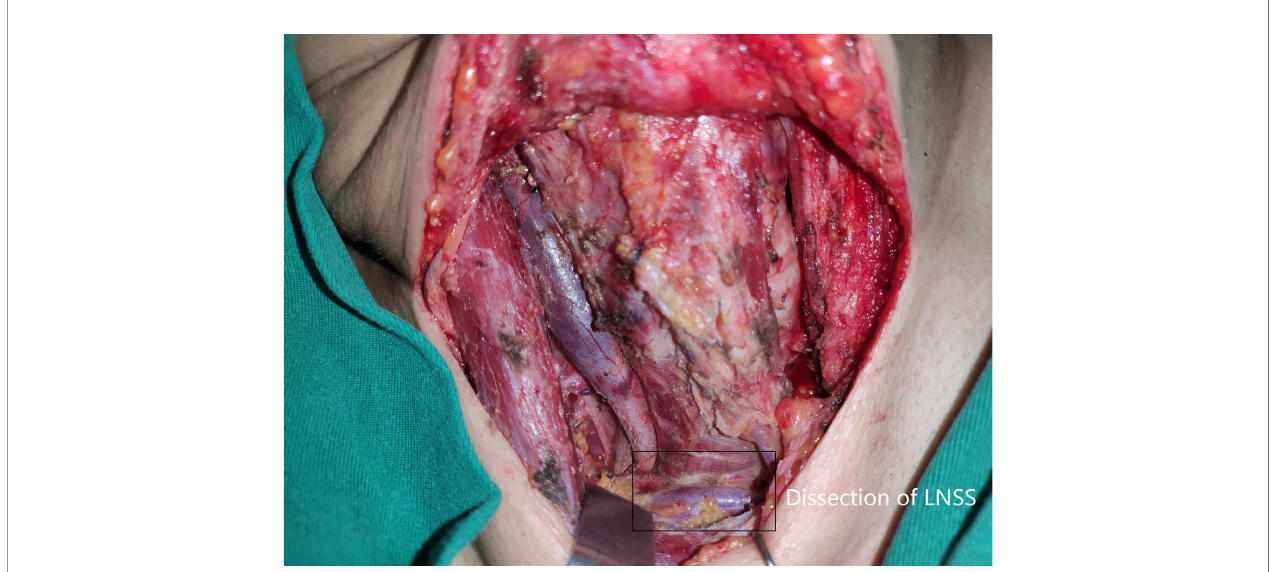
FIGURE 2 | Dissection (black box) of lymph node between sternocleidomastoid and sternohyoid muscles